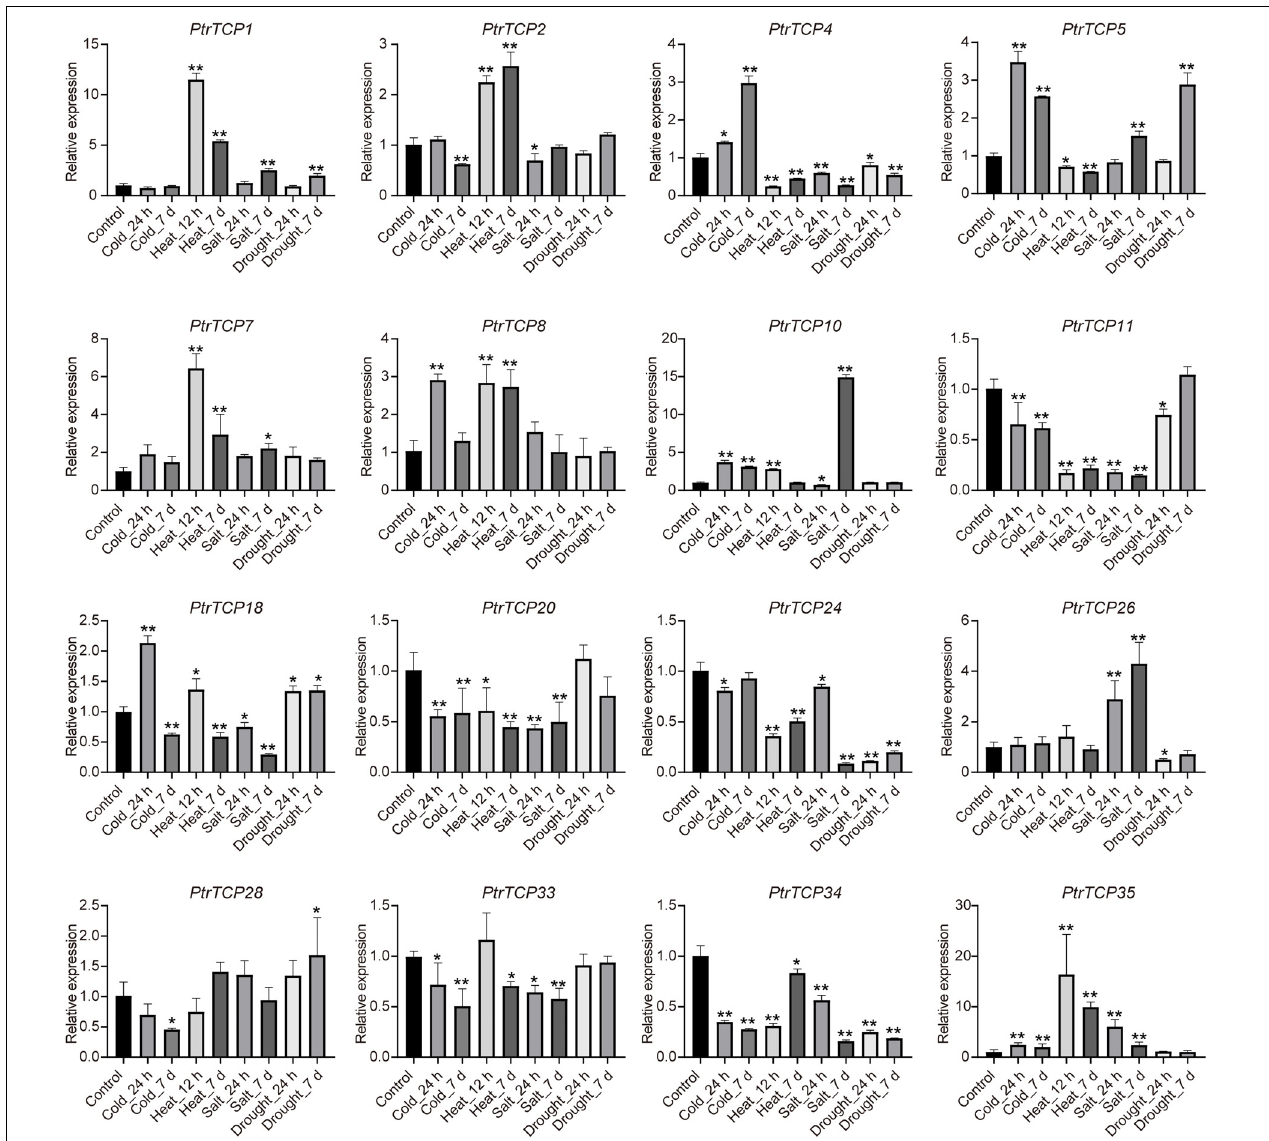
FIGURE 6 | qRT-PCR validation of the selected PtrTCP genes in leaf response to abiotic stresses. The relative expression level of each PtrTCP gene was normalized to PtrHIS (Potri.005G072300), Ptr60S (Potri.007G093700), PtrACTIN (Potri.019G010400) , and PtrACTIN2 (Potri.001G309500) . The expression values are the means of three technical replicates, and asterisks represent a significant difference between each stress treatment and negative control ( *p < 0.05, **p < 0.01; Student’s t -test). Each qRT-PCR experiment was performed with three independent biological replicates, and the error bars represent